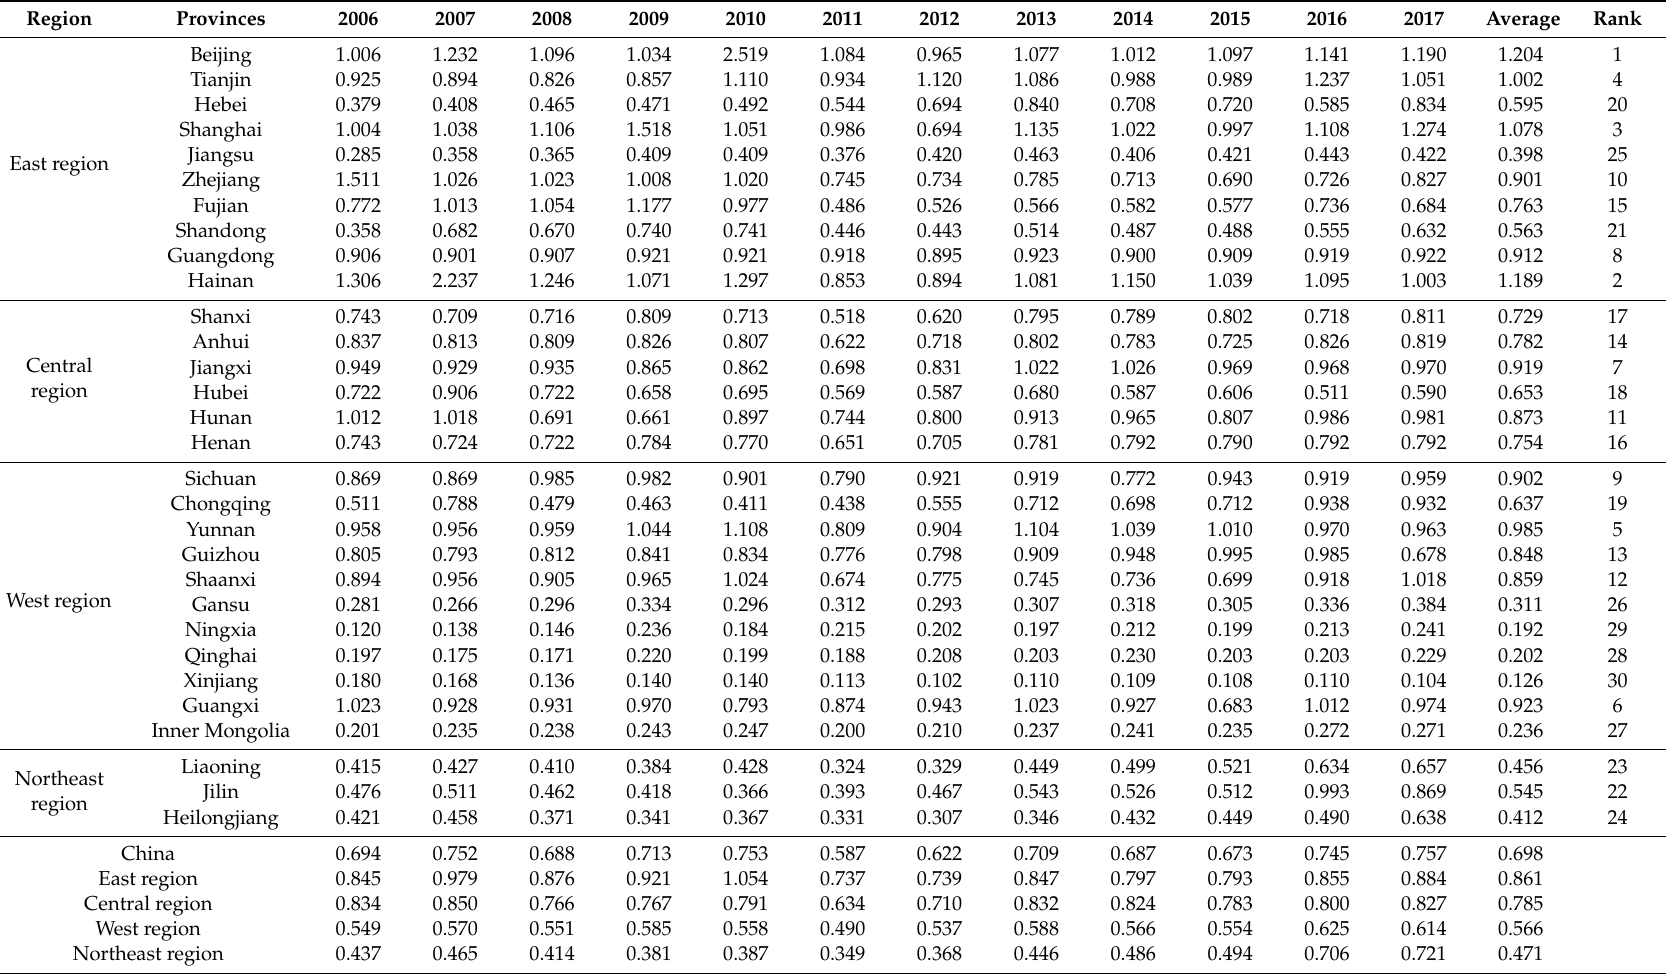
Table 3. The EWPs of 30 provinces during